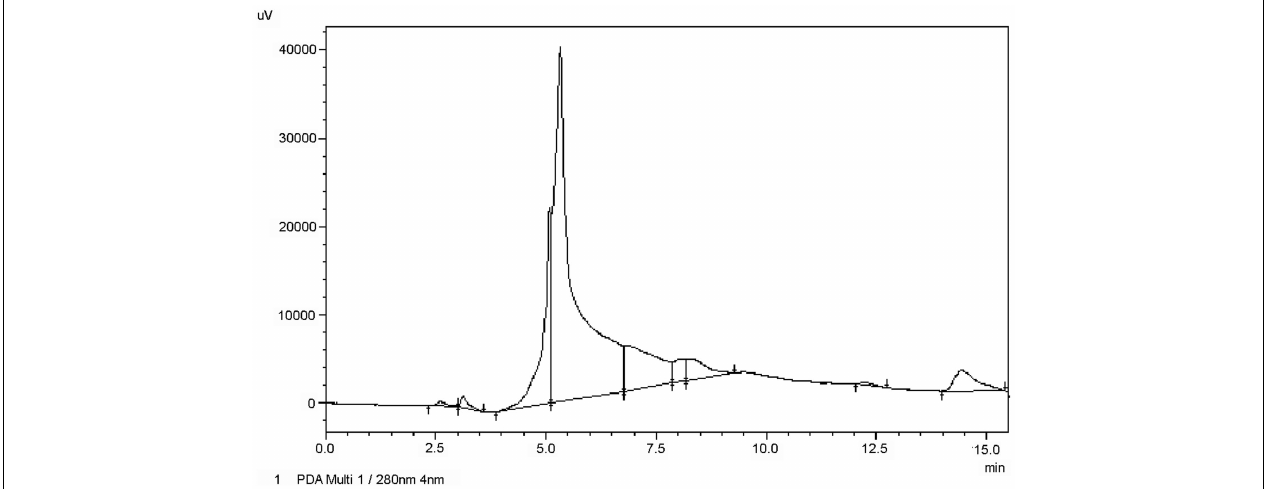
FIGURE 1 | Chromatography of purified IgM from S. salar . The IgM of Atlantic salmon previously separated by SEC was subjected to HPLC on dC18 column (Waters) and eluted under isocratic conditions. The chromatography was monitored at 280nm.